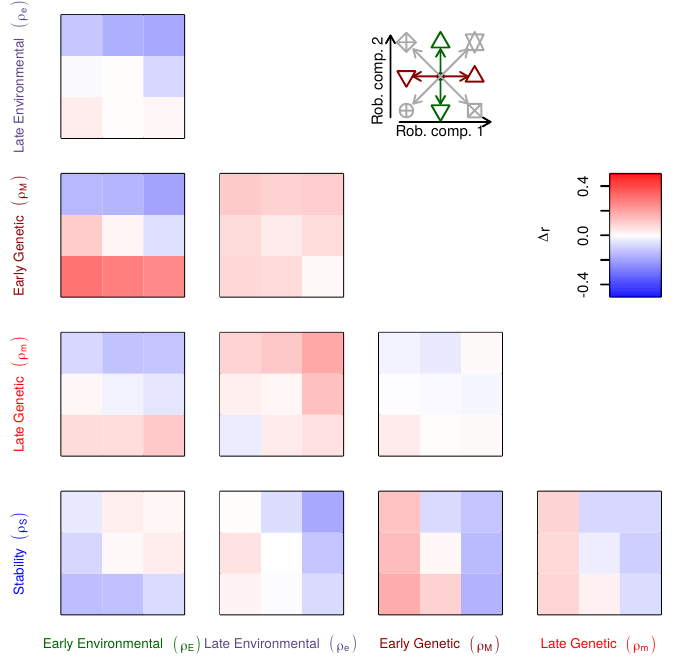
Figure SI9 – Evolution of correlations. Evolution of the mutational correlation among ro- bustness components after 10,000 generations of evolution ( ∆ r = r 10,0000 over 100 simulation replicates. For each pair of robustness components, nine selection gradients were simulated (including control simulations without selection on robustness, central